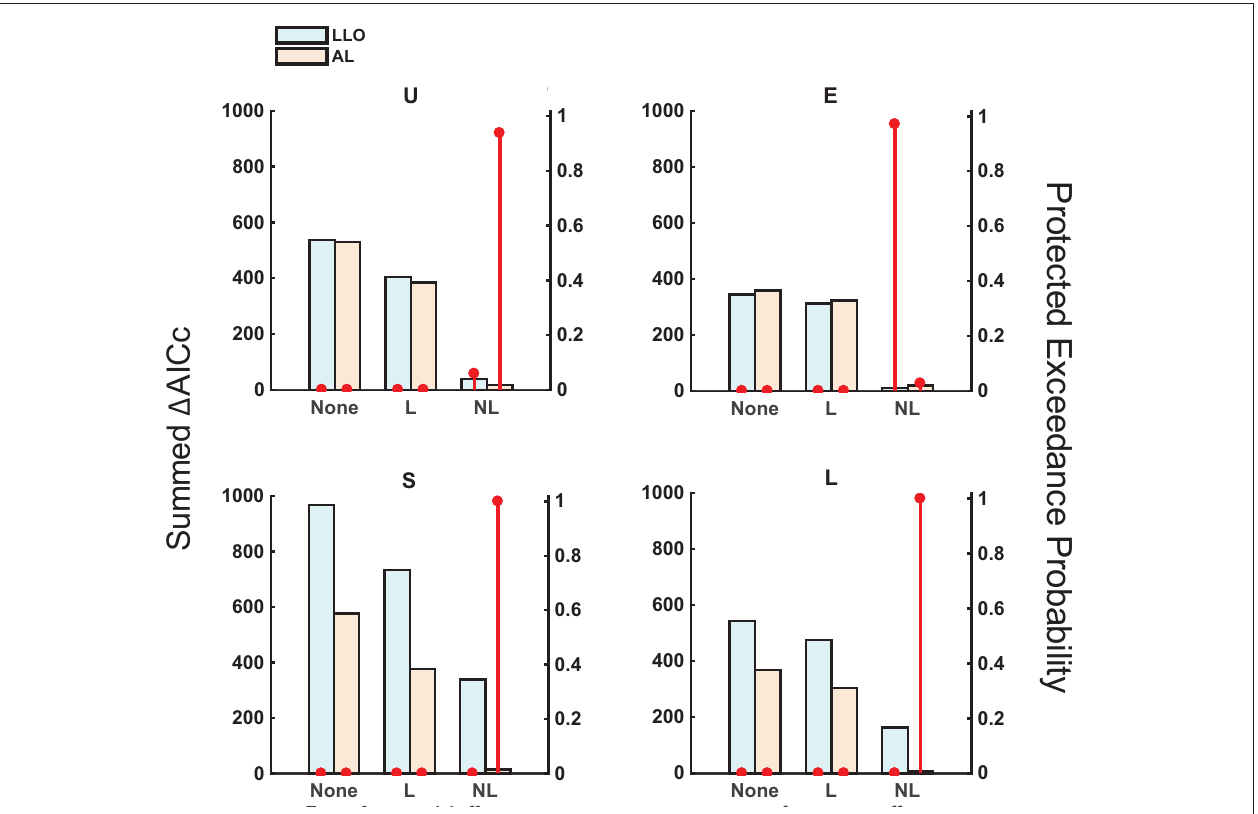
FIGURE 5 | Model comparison: AICc and protected exceedance probability. The assumptions of the models differed in two dimensions: (1) without adaptation (LLO) or with adaptation (AL), and (2) without sequential effects (“None”), with linear sequential effects (“L”), or with non-linear sequential effects (“NL”). The summed AICc (bars, left axis, the lower the better) and protected exceedance probability (red dots, right axis, the probability that a specific model excels the other models considered, the higher the better) are plotted for each model and each distribution condition. For all except the E condition, the AL-NL model had an overwhelming advantage over the other